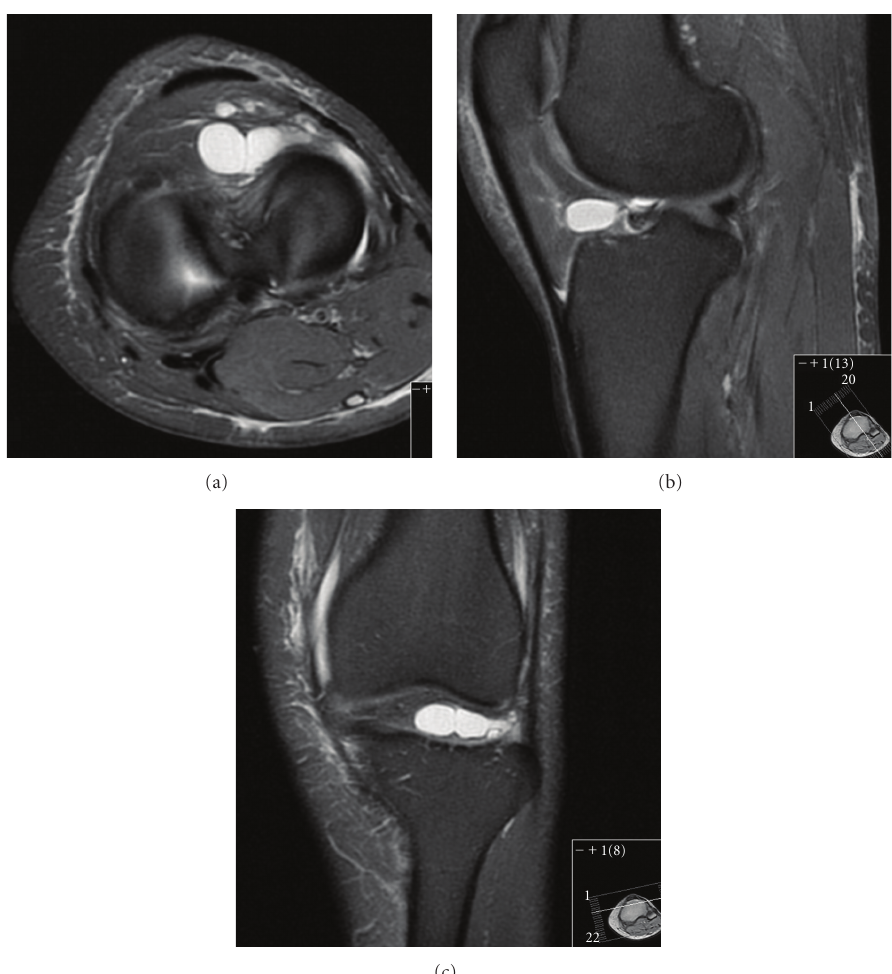
Figure 3: Axial/sagittal/coronal FD FS MRI showing a large multilocular cystic swelling arising from the ACL tibial footprint extending to the infrapatellar fat